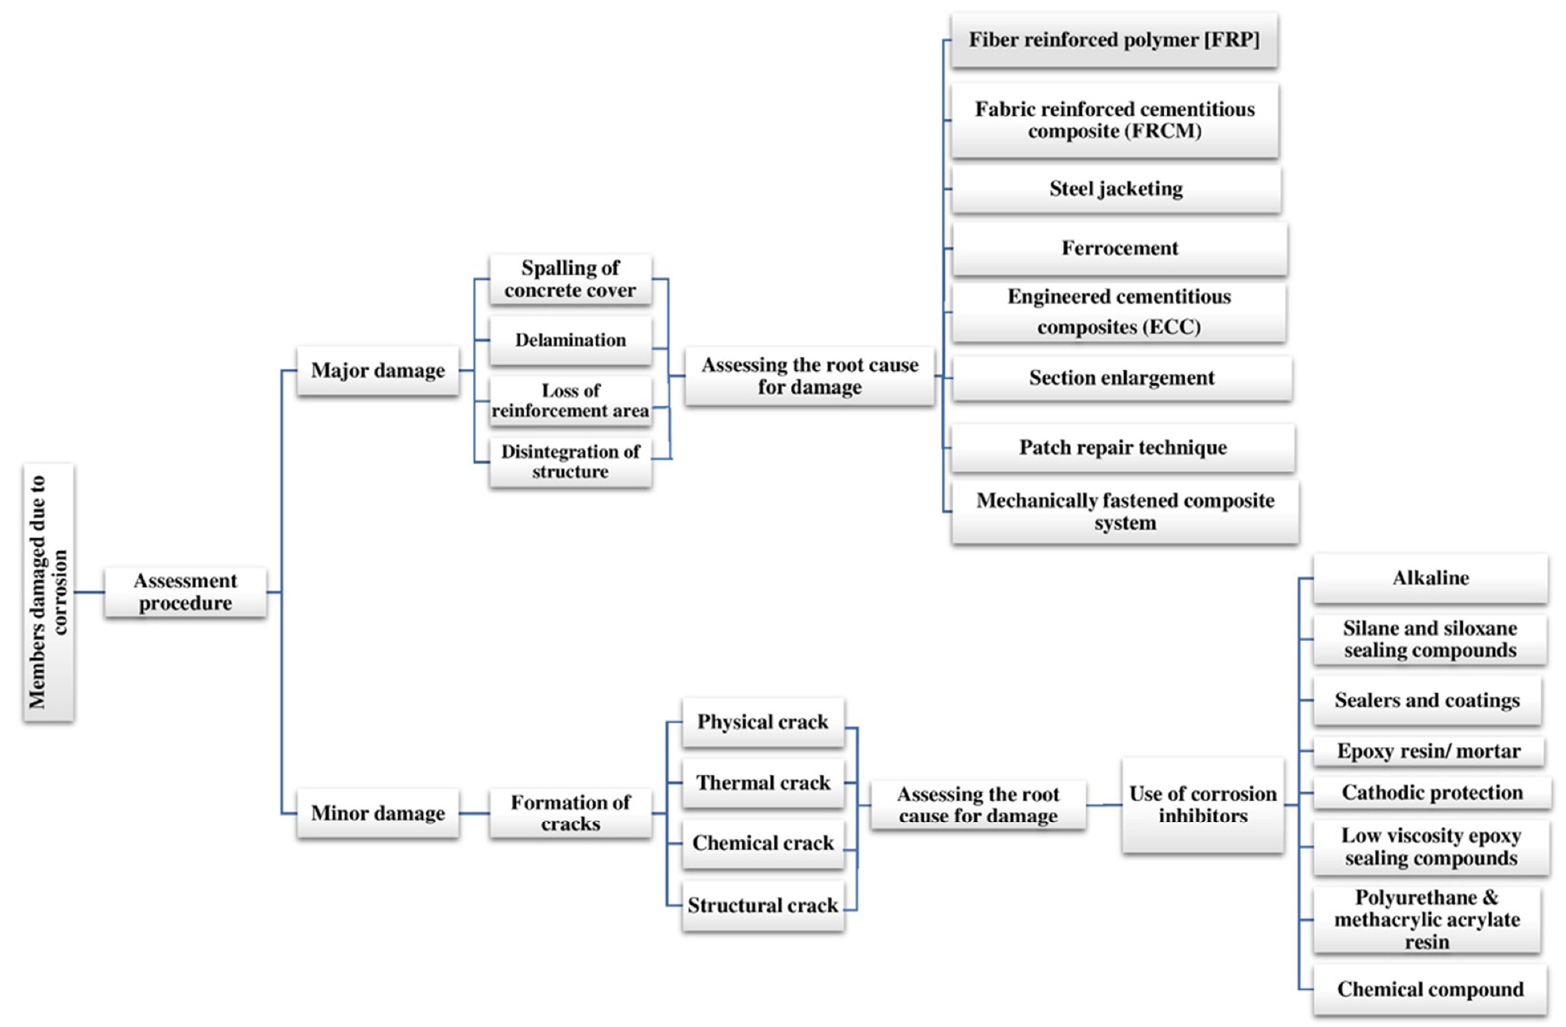
Figure 14. Assessment procedure for corrosion-damaged RC structures.